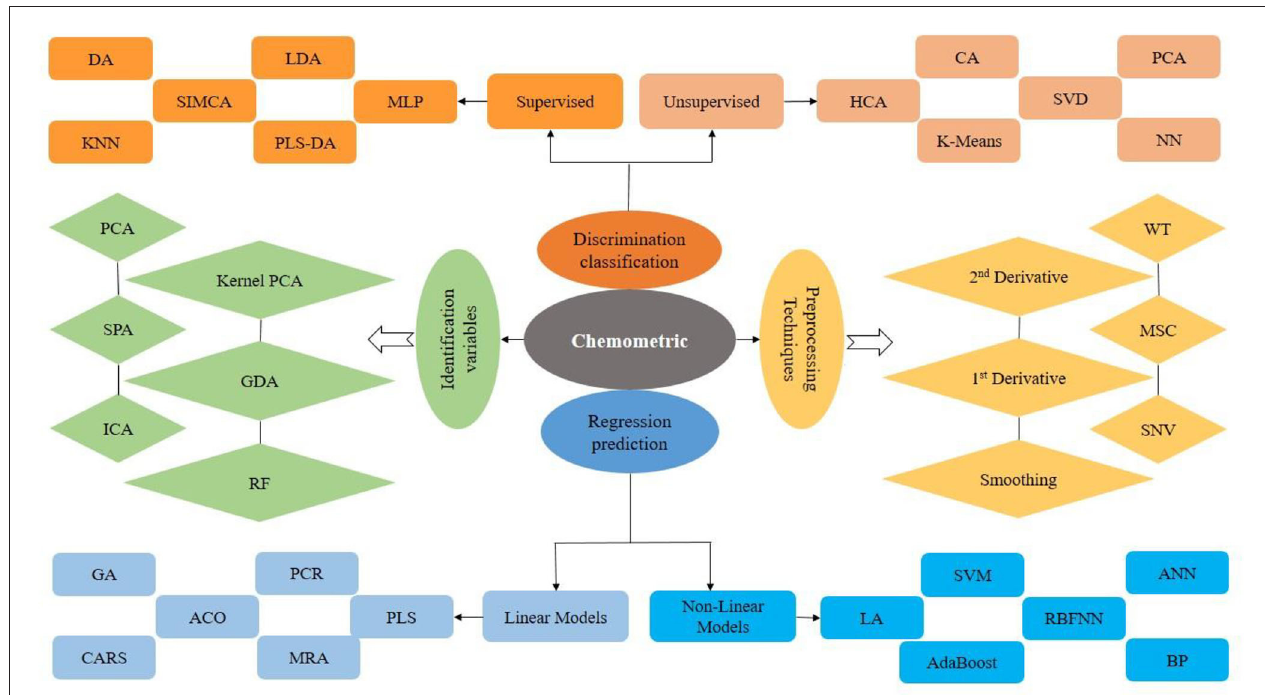
FIGURE 1 | Chemometric models used in spectral imaging and spectroscopic techniques for classification and regression